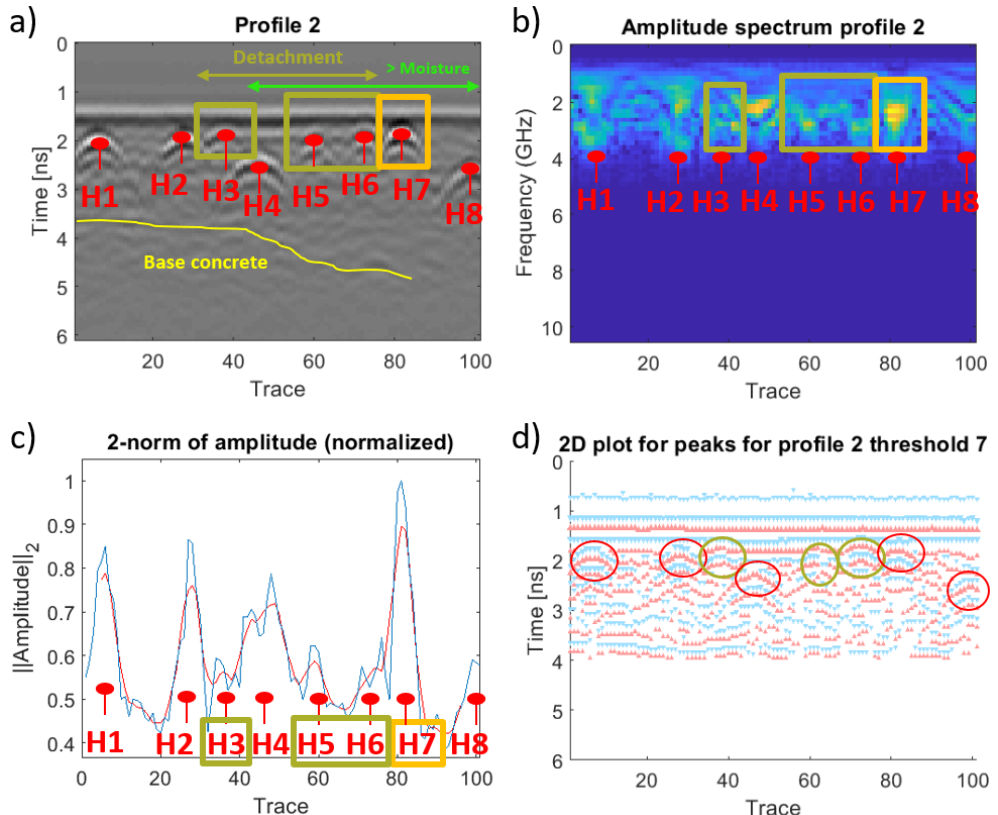
Figure 6. Graphics obtained for GPR profile 2 and interpretation. The olive-green rectangles in ( a – c ) represent voids or delamination and orange rectangles indicate open-air rebars. The red circles in ( d ) represent a positive polarity of the reflections produced by the rebars, while the olive-green circles represent a negative signal polarity due to the presence of voids.